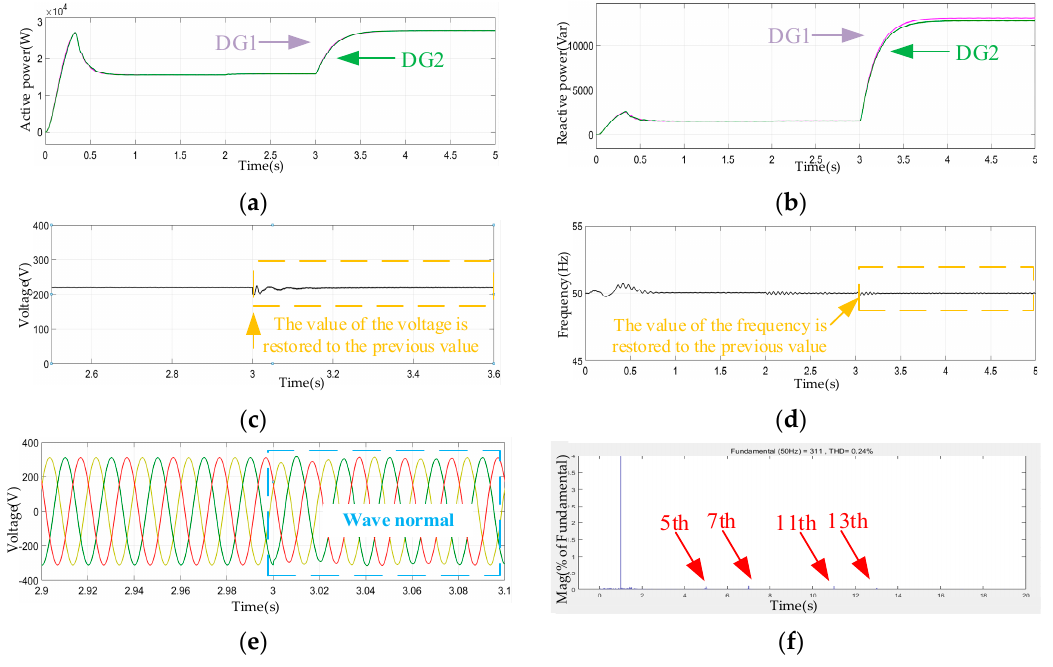
Figure 12. ( a ) Active power of DG1 and DG2 Inverters; ( b ) Reactive power of DG1 and DG2 Inverters; ( c ) The voltage value of PCC; ( d ) The frequency value of PCC; ( e ) Voltage waveform of PCC; ( f ) Voltage FFT analysis of PCC.